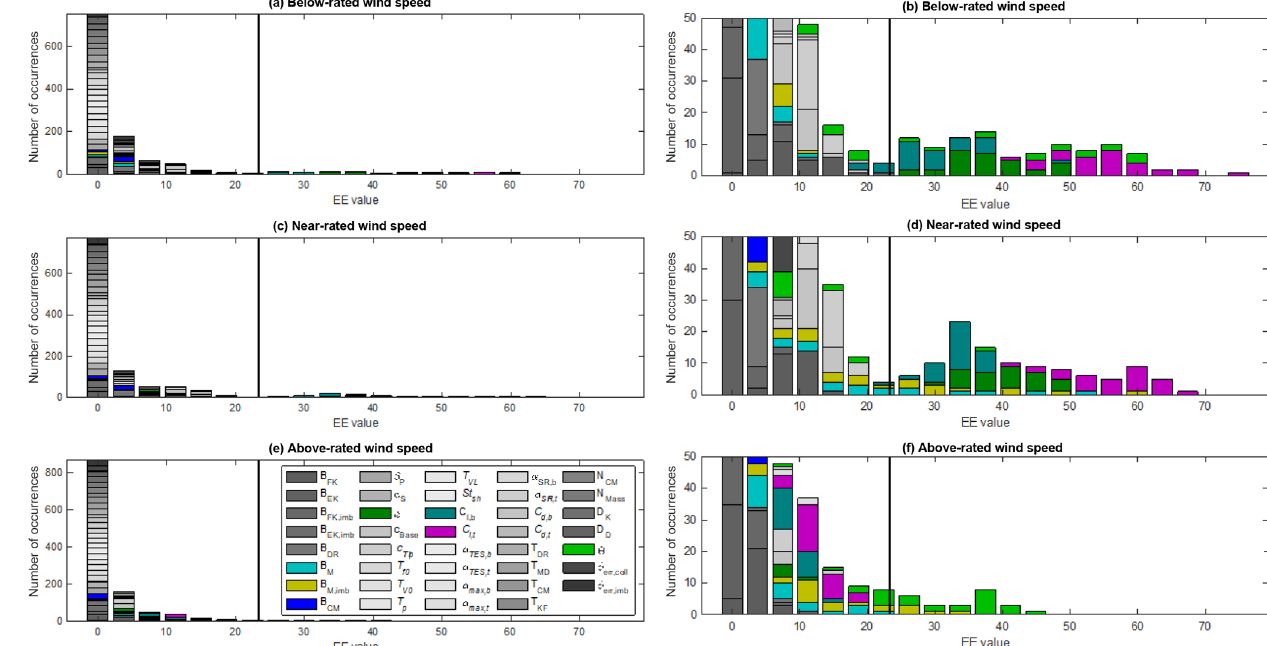
Figure 17. EE-value histograms of blade-root OoP bending fatigue moment. Each graph shows one wind speed bin and includes all input parameters. Right column is a zoomed-in view of the left column.